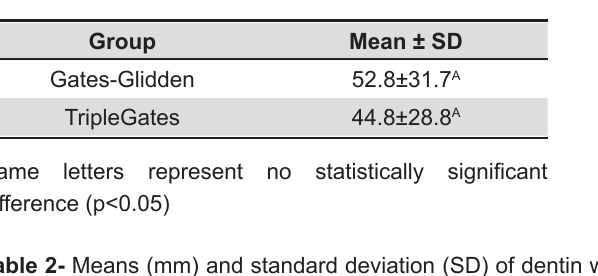
Table 1- Mean and standard deviation (SD) of the canal area increase in percentages after the use of the tested instruments